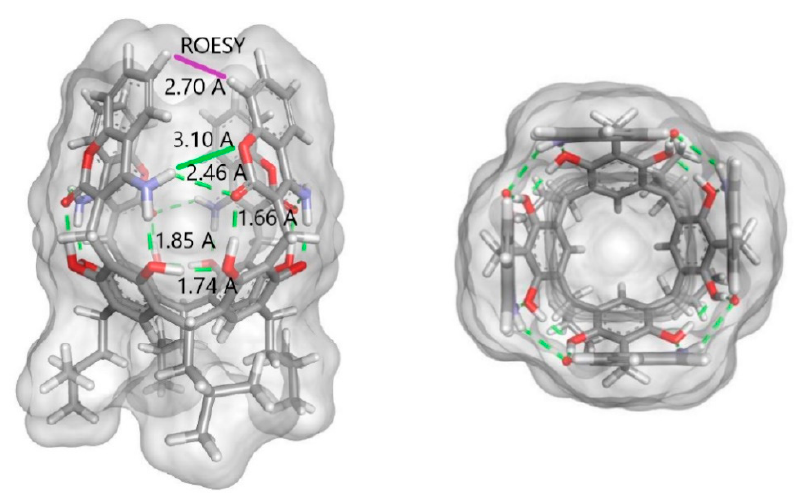
Figure 5. The structure of the aminocoumarin derivative of the resorcin[4]arene calculated by the DFT/B3LYP method in CHCl 3 . The side projection is given on the left , with the top projection on the right .